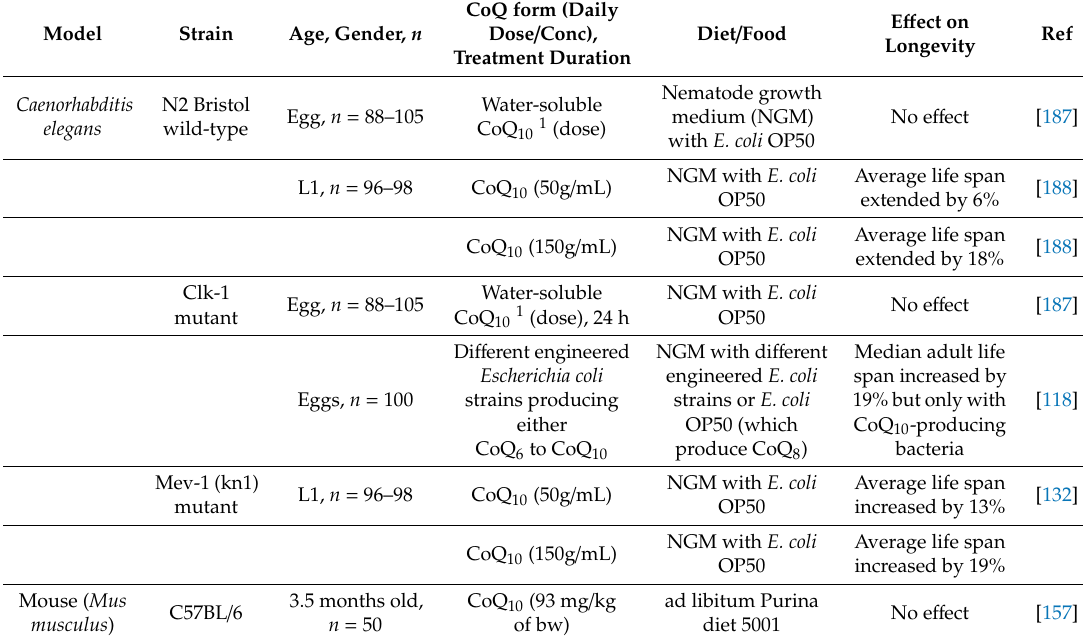
Table 1. Coenzyme CoQ treatment e ff ects on life span of di ff erent animal